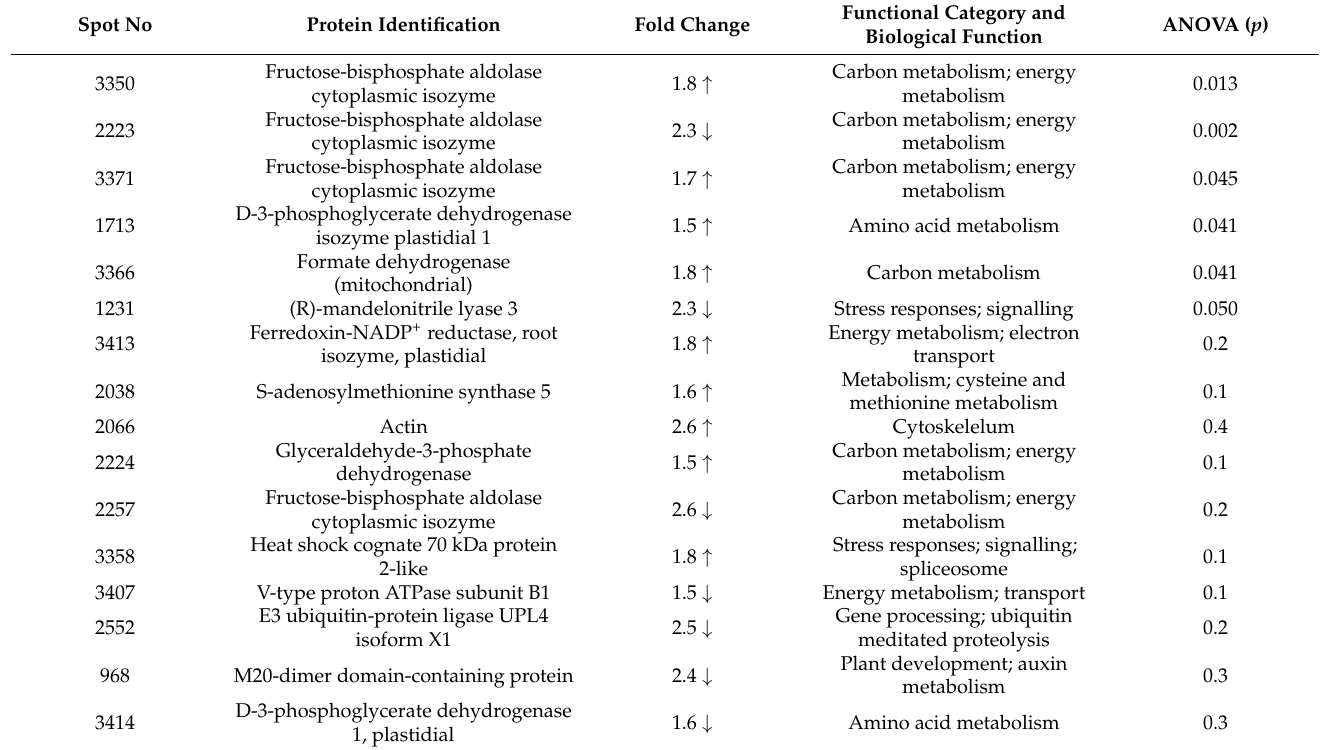
Figure 2. Representative 2-DE IEF-SDS PAGE protein profile maps of in vitro cultured whole-root extracts from Masto de Montañana. The roots were grown in 0 mM NaCl, (panel ( A )) and supplemented with 60 mM NaCl (panel ( B )). Figure 2 provides a general overview of the amount of proteins detected. Table 3. Differentially expressed proteins in in vitro cultured roots subject to salt stress. Fold change indicates the relative expression in 60 mM NaCl versus 0 mM NaCl in the culture media. Identification of the protein spots by MALDI-TOF/TOF with significant changes: p < 0.05 in the first six or p > 0.05 in the rest). The assigned protein is the best match found using Mascot. ↑ upregulated and ↓ downregulated